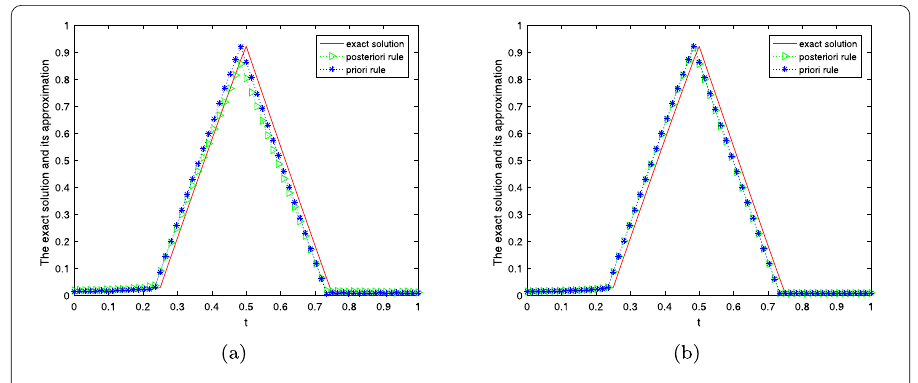
Figure 4 The comparison of the exact solution and its approximation solution for α = 0.3 at x = 0.1 with Example 5.2, ( a ) (cid:13) = 0.001, ( b ) (cid:13) = 0.0001